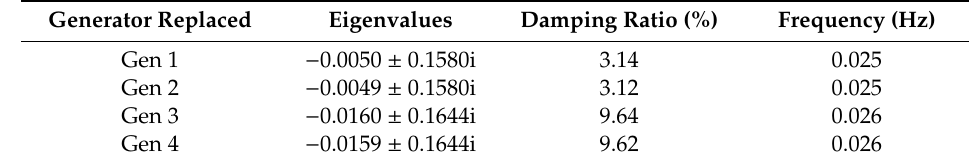
Table 5. The ultralow-frequency oscillation modes by replacing a